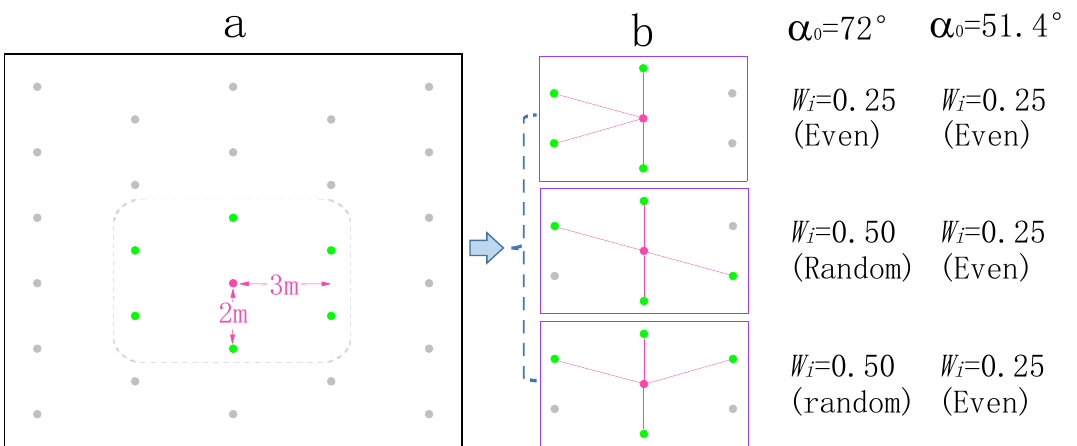
Figure 2. Different standard angles were used to judge the distribution pattern of the same single tree. ( a ) Six nearest adjacent trees of a reference tree in a regularly planted stand. ( b ) When n = 4, the four nearest neighbors of the reference tree may have three forms. The reference tree is represented by a red circle, the nearest adjacent trees are represented by a green circle, and α 0 represents the standard angle. W i represents the uniform angle index of each individual.